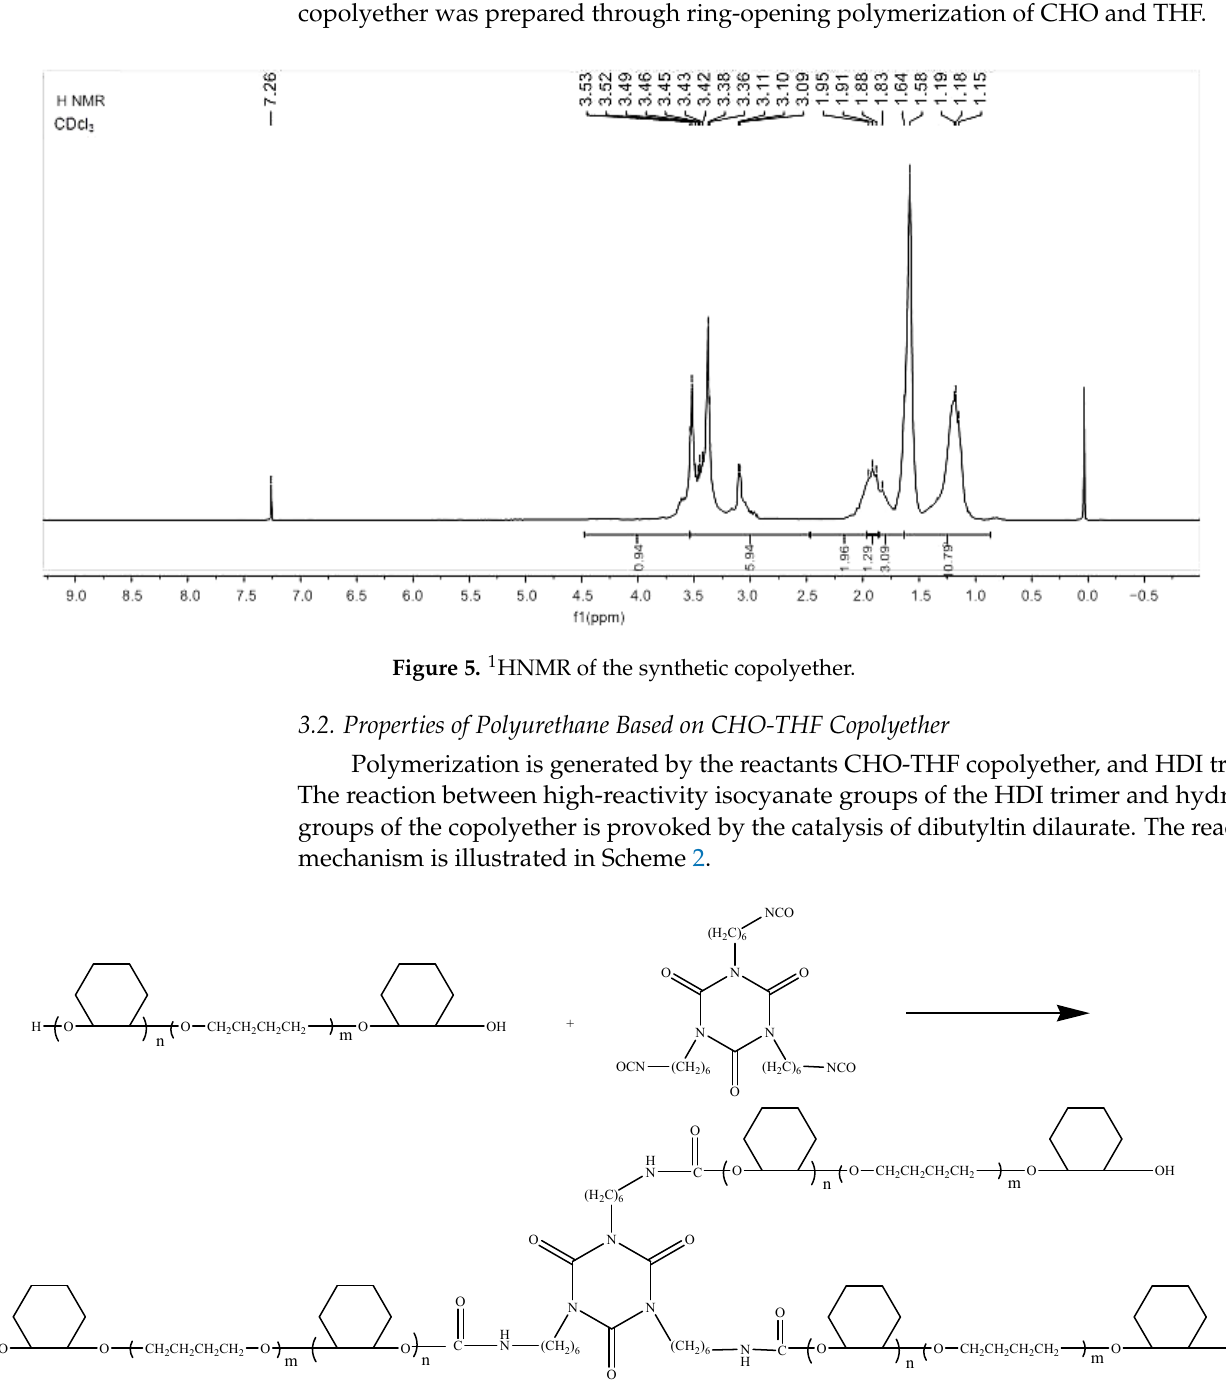
Scheme 2. Reaction mechanism of